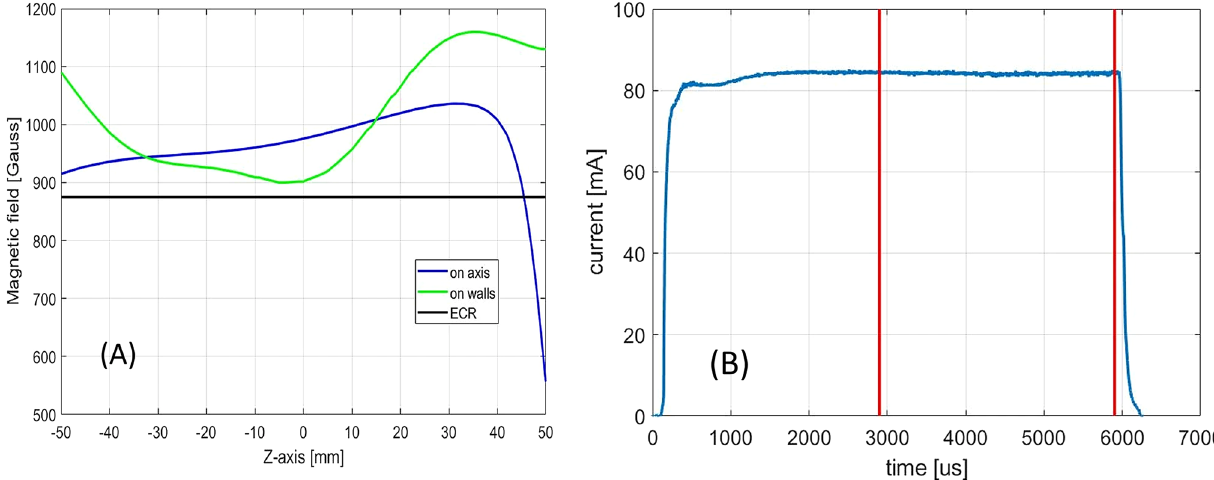
Figure 4. ( A ) Magnetic field configuration at the centre of the high current region; ( B ) correspondent beam pulse shape produced: only the beam produced within the red lines is transmitted to the